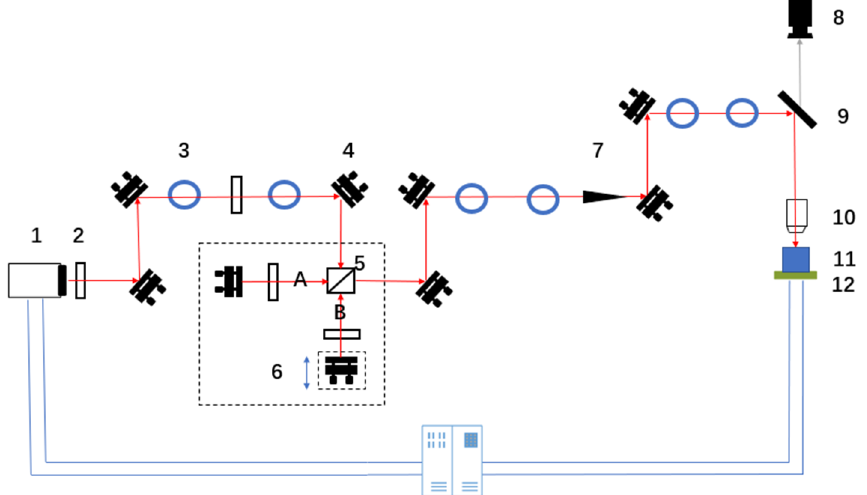
Figure 1. Schematic of the light path in the experiment (1—fs laser; 2—neutral density filter; 3—diaphragm; 4—mirror; 5—beam splitter; 6—one-dimensional linear translation stage; 7—shutter; 8—CCD camera; 9—dichroic mirror; 10—plano-convex lens; 11—sample; 12—six-degrees-of-freedom translation stage).